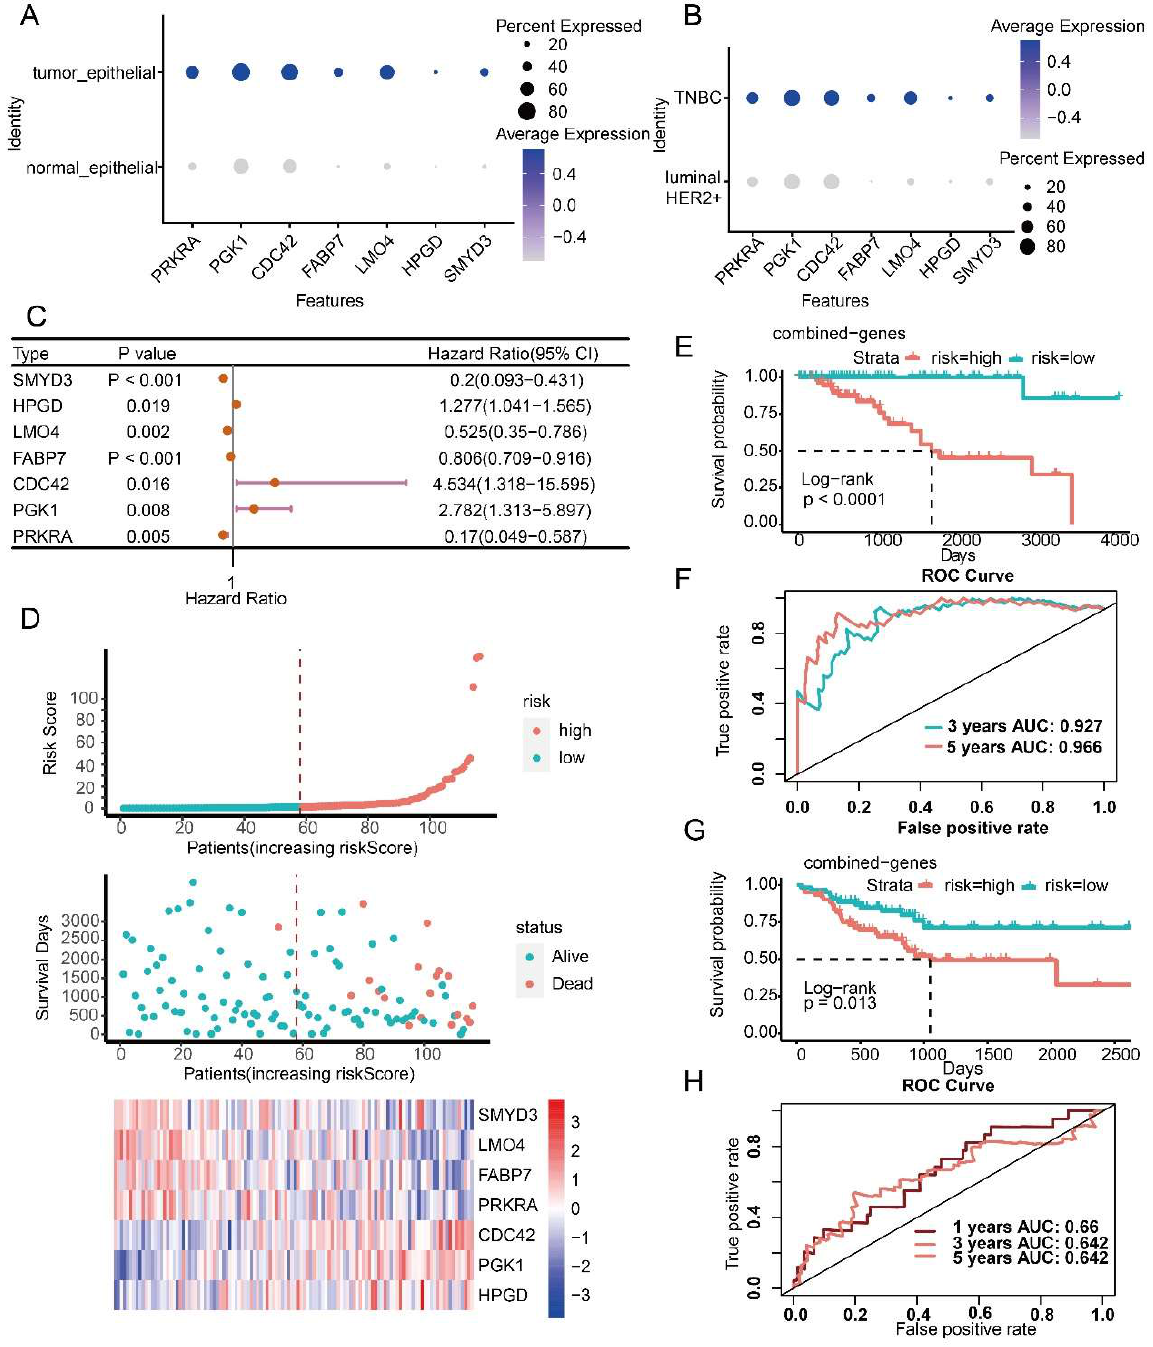
Figure 7. Construction and evaluation of the prognostic risk model for TNBC. ( A ) Expression levels of prognostic factors between normal and cancer cells. ( B ) Expression levels of prognostic factors in cancer cells of TNBC and other subtypes. ( C ) HR and p values of prognostic factors by univariate Cox regression. ( D ) Risk curves and scatter plots of sample survival probability for each sample reordered by risk score, heatmap of expression of prognostic factors in low-risk and high-risk groups. ( E ) Differences in overall survival between high-risk and low-risk groups in the training cohort of TNBC. ( F ) Receiver operating characteristic curve (ROC) analysis of the sensitivity and specificity of the prognostic model in the training cohort of TNBC. ( G ) Differences in overall survival between high-risk and low-risk groups in the external validation cohort of TNBC. ( H ) ROC analysis of the sensitivity and specificity of the prognostic model in the external validation cohort of TNBC.